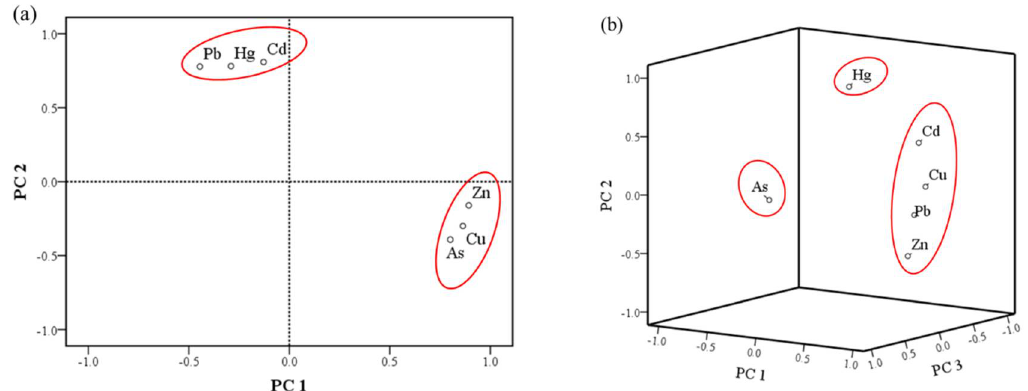
Figure 6. The results of PCA of six toxic elements in the agricultural soils of Jilin Province: ( a ) the Midwest; ( b ) the East.